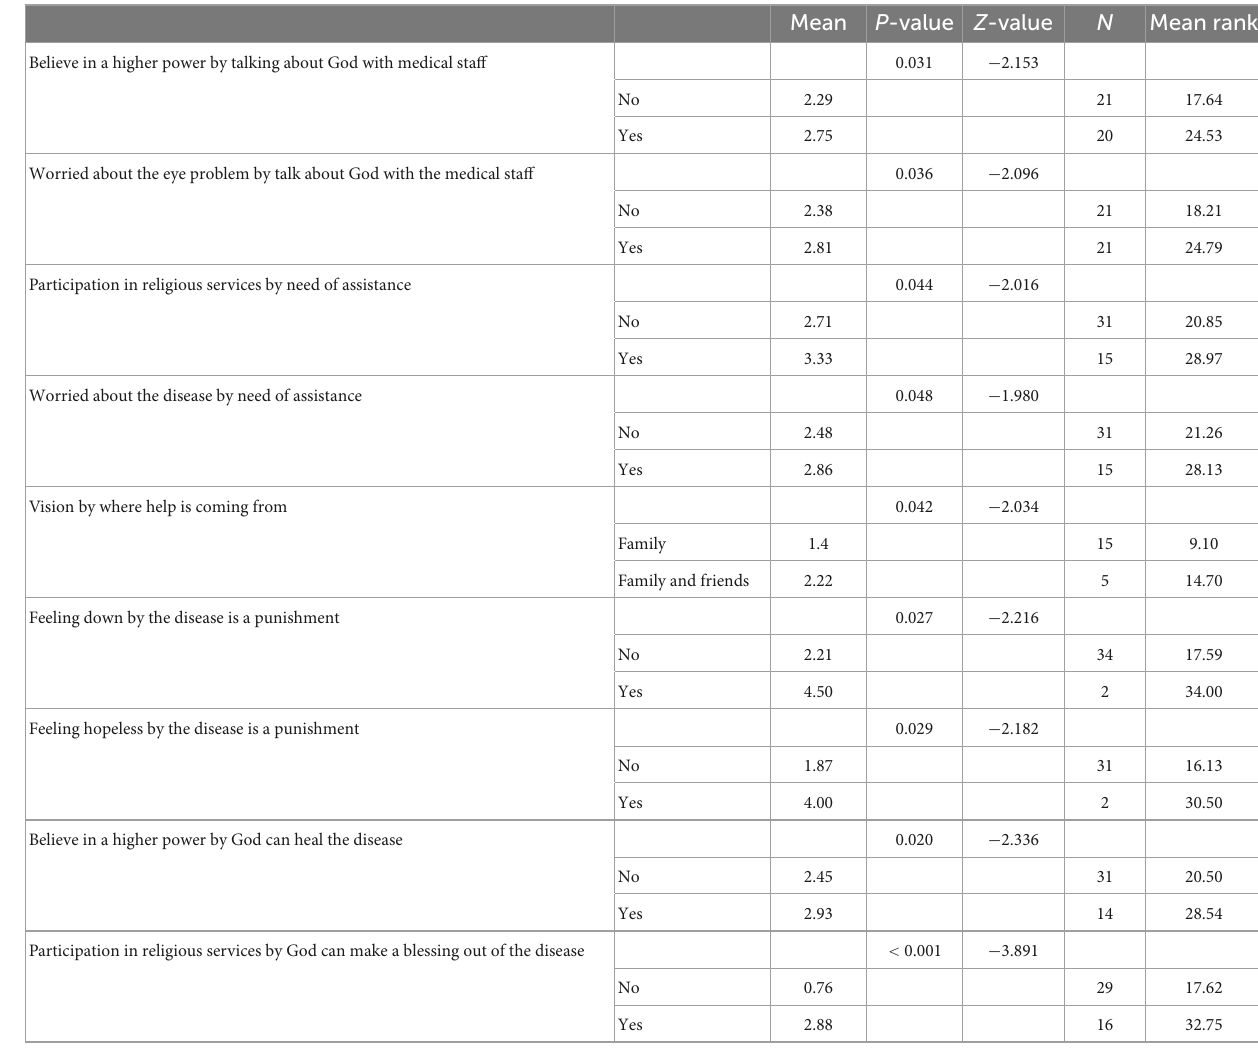
TABLE 7 The results of the Wilcoxon Rank-Sum test of the Romanian group.